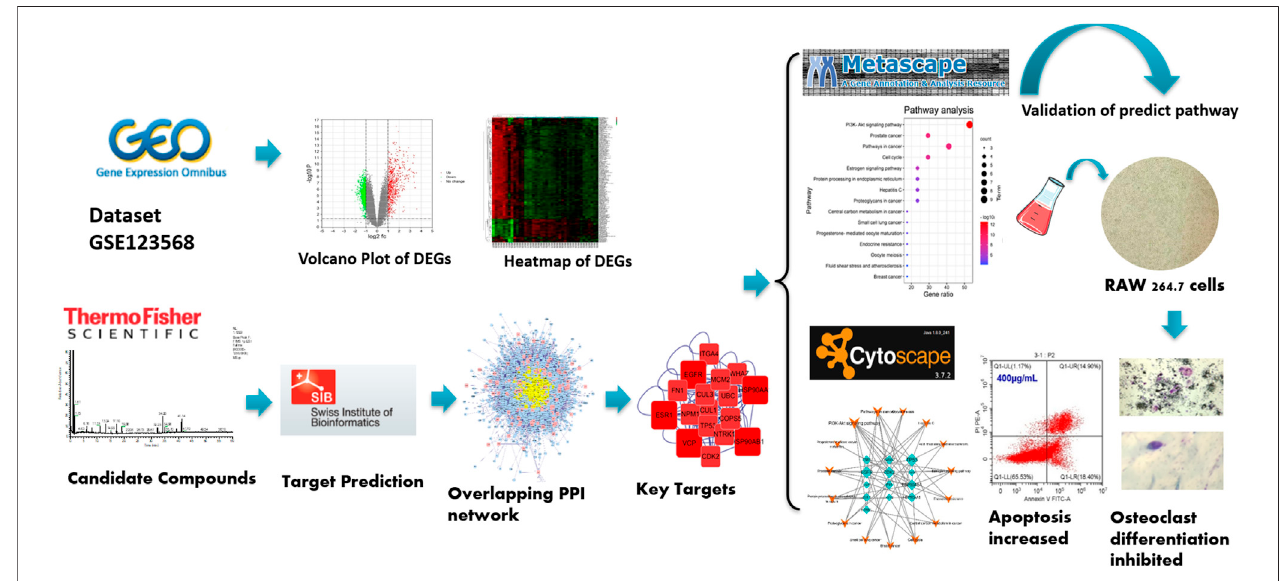
FIGURE 1 | Whole experiment process in our